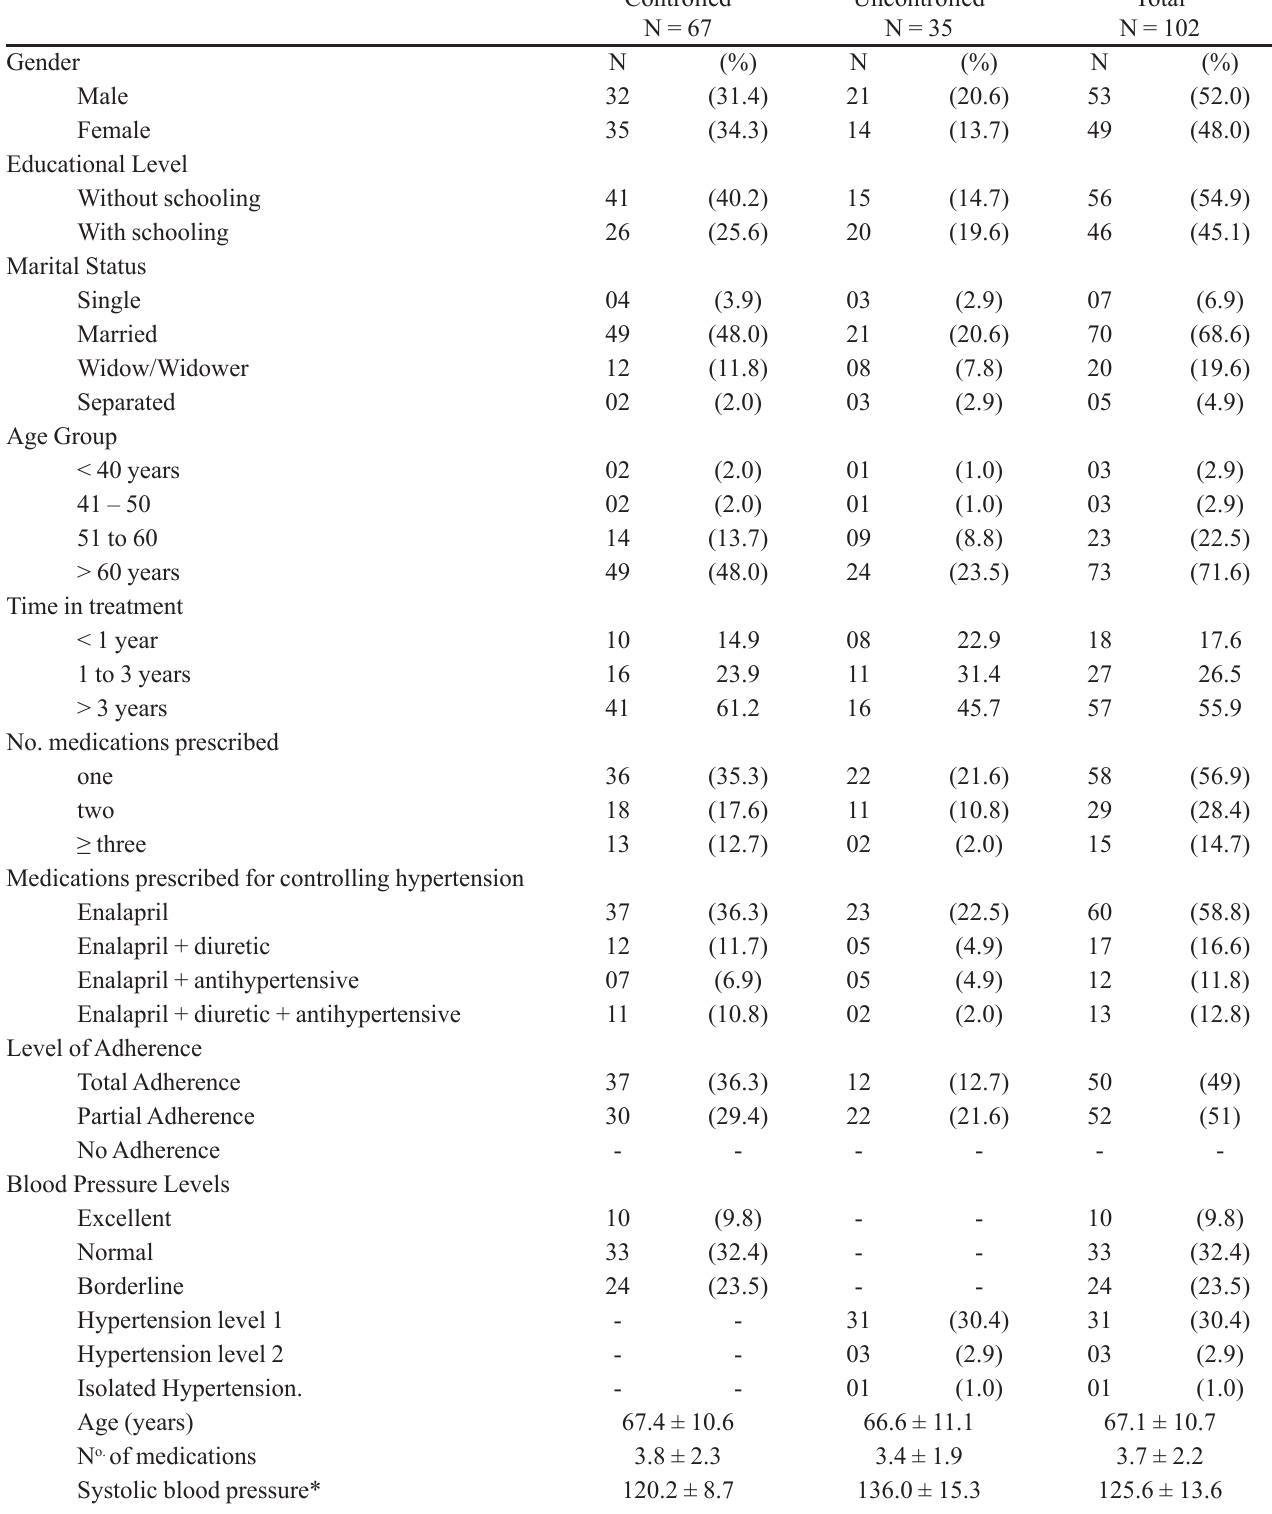
TABLE I - Distribution of controlled and uncontrolled hypertensive patients according to sociocultural and disease